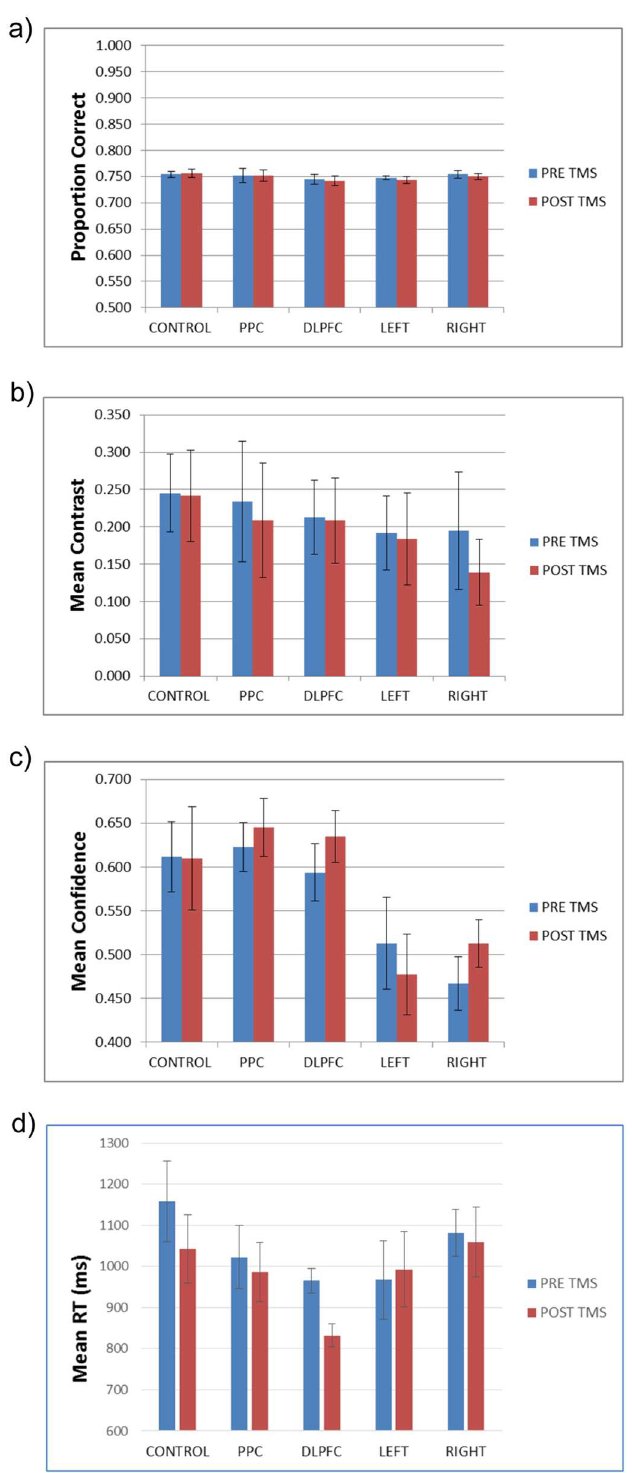
Fig 2. Task performance. Pre and post-TMS performance measures for the different groups. a) Proportion correct. B) Mean contrast C) Mean confidenceD) ReactionTime for correct responses. DLPFC = bilateral DLPFC group, PPC = bilateralposterior parietalcortex group, LEFT = left posterior parietalcortex and DLPFC group, RIGHT = right posterior parietal cortex and DLPFC group. All error bars are SE.